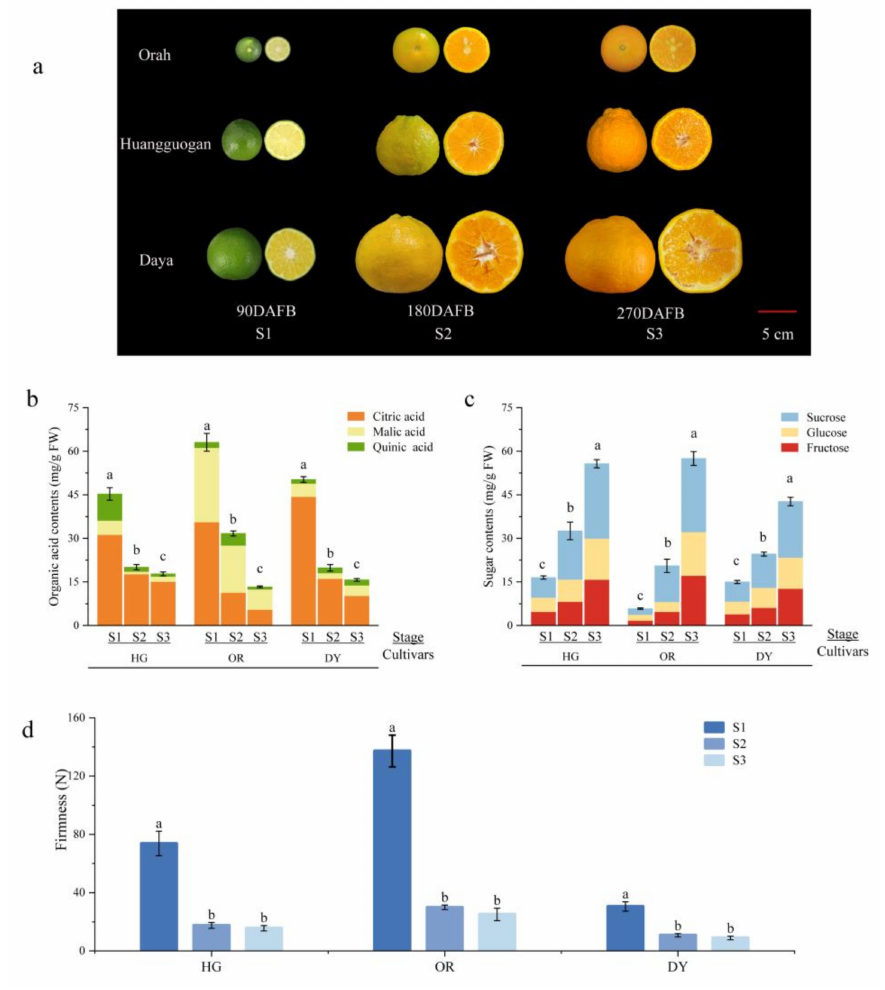
Figure 1. ( a ) Morphological changes during fruit development and ripening of the three cultivars. Changes in organic acid content ( b ) and sugar content ( c ) during fruit development and ripening. Error bars indicate the standard error of total substance content, and different letters indicate signifi- cant differences in total content, p < 0.05. ( d ) Changes in fruit firmness during fruit development and ripening. S1, stage 1; S2, stage 2; S3, stage